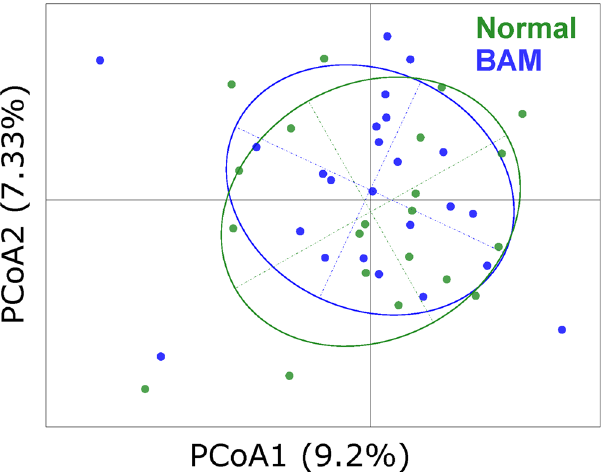
Figure 5. Principal coordinate analysis of IBS patients who had undergone SeHCAT assay to detect bile acid malabsorption (BAM). Samples were categorized as normal (n = 21) (> 20% SeHCAT retention) or having borderline to severe BAM (< 20% SeHCAT retention) (n = 24). There was no significant difference between the BAM classes (Adonis p-value =